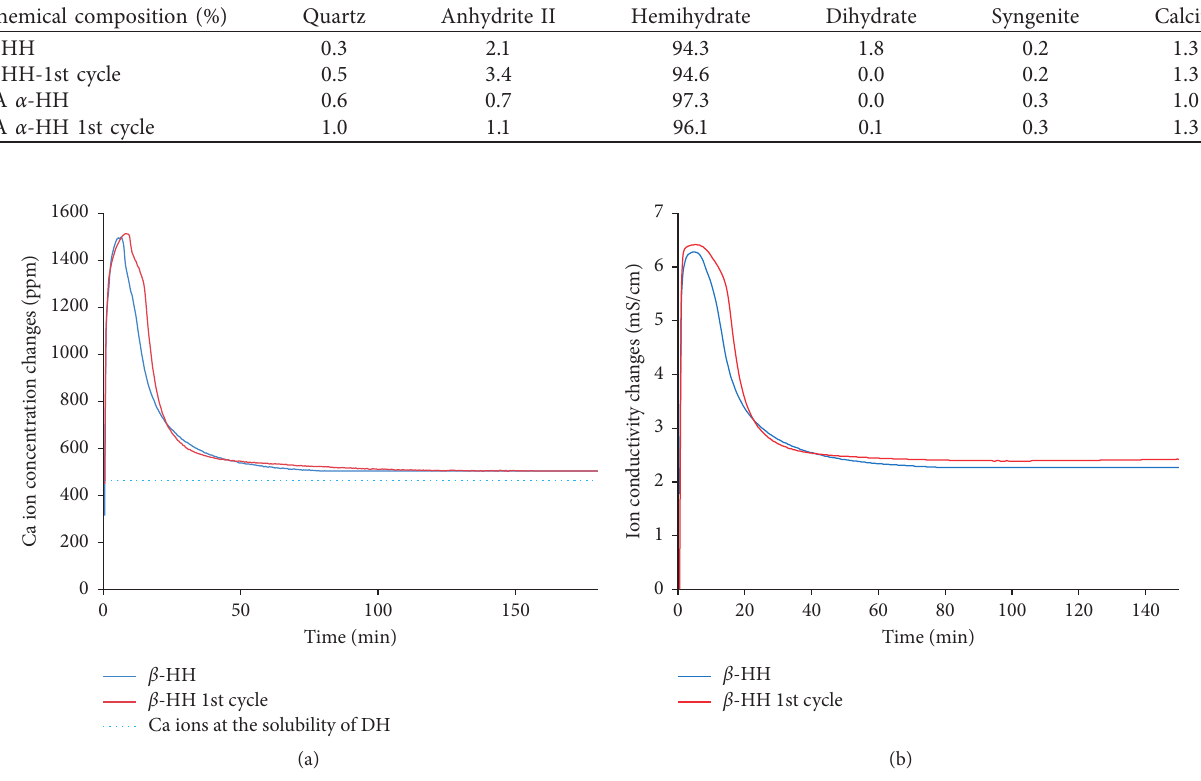
Figure 3: Ca 2+ -Ion concentration and ion conductivity changes for pure β -HH and β -HH after the first cycle: (a) ion concentration changes and (b) ion conductivity changes.